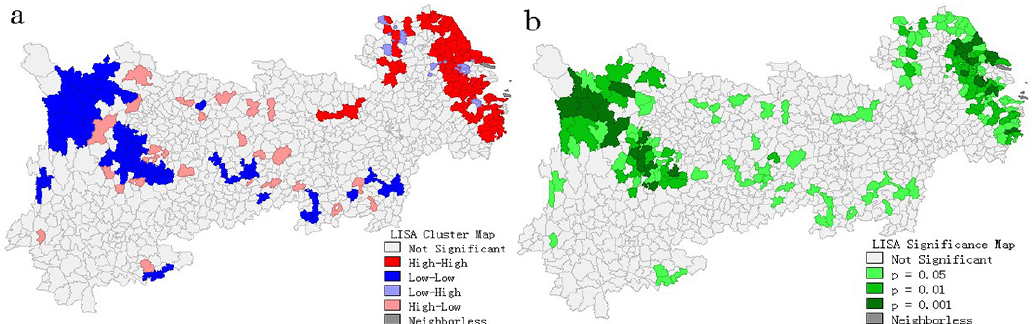
Figure 10. Urban space agglomeration map and saliency map of YREB the in 2006. ( a ) LISA cluster map of the YREB in 2006, ( b ) LISA significance map of the YREB in 2006.